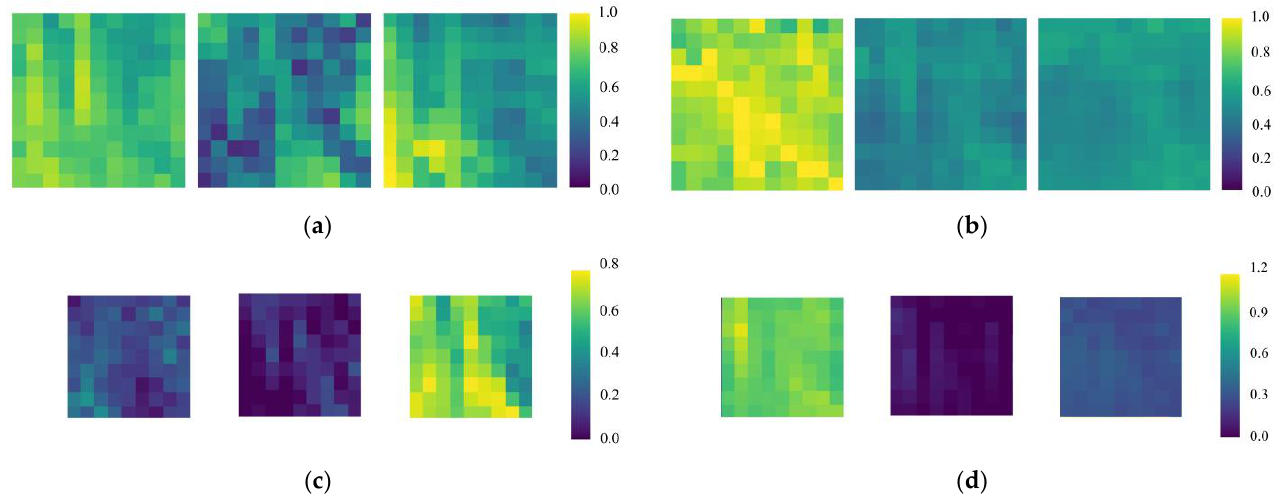
Figure 10. Visualization process of dual-channel CNN. ( a ) Visual images of the X-Bragg-CNN input. ( b ) Visual images of